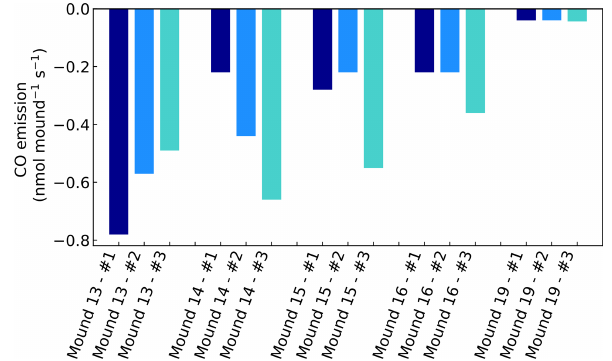
Figure A1. CO emissions of valley mound nos. 13–19, expressed in nmolmound − 1 s − 1 , which represents a collar area of 0.25m 2 . All mounds were measured three times during one week and each series no. (#) was measured on the same day and in the same order.